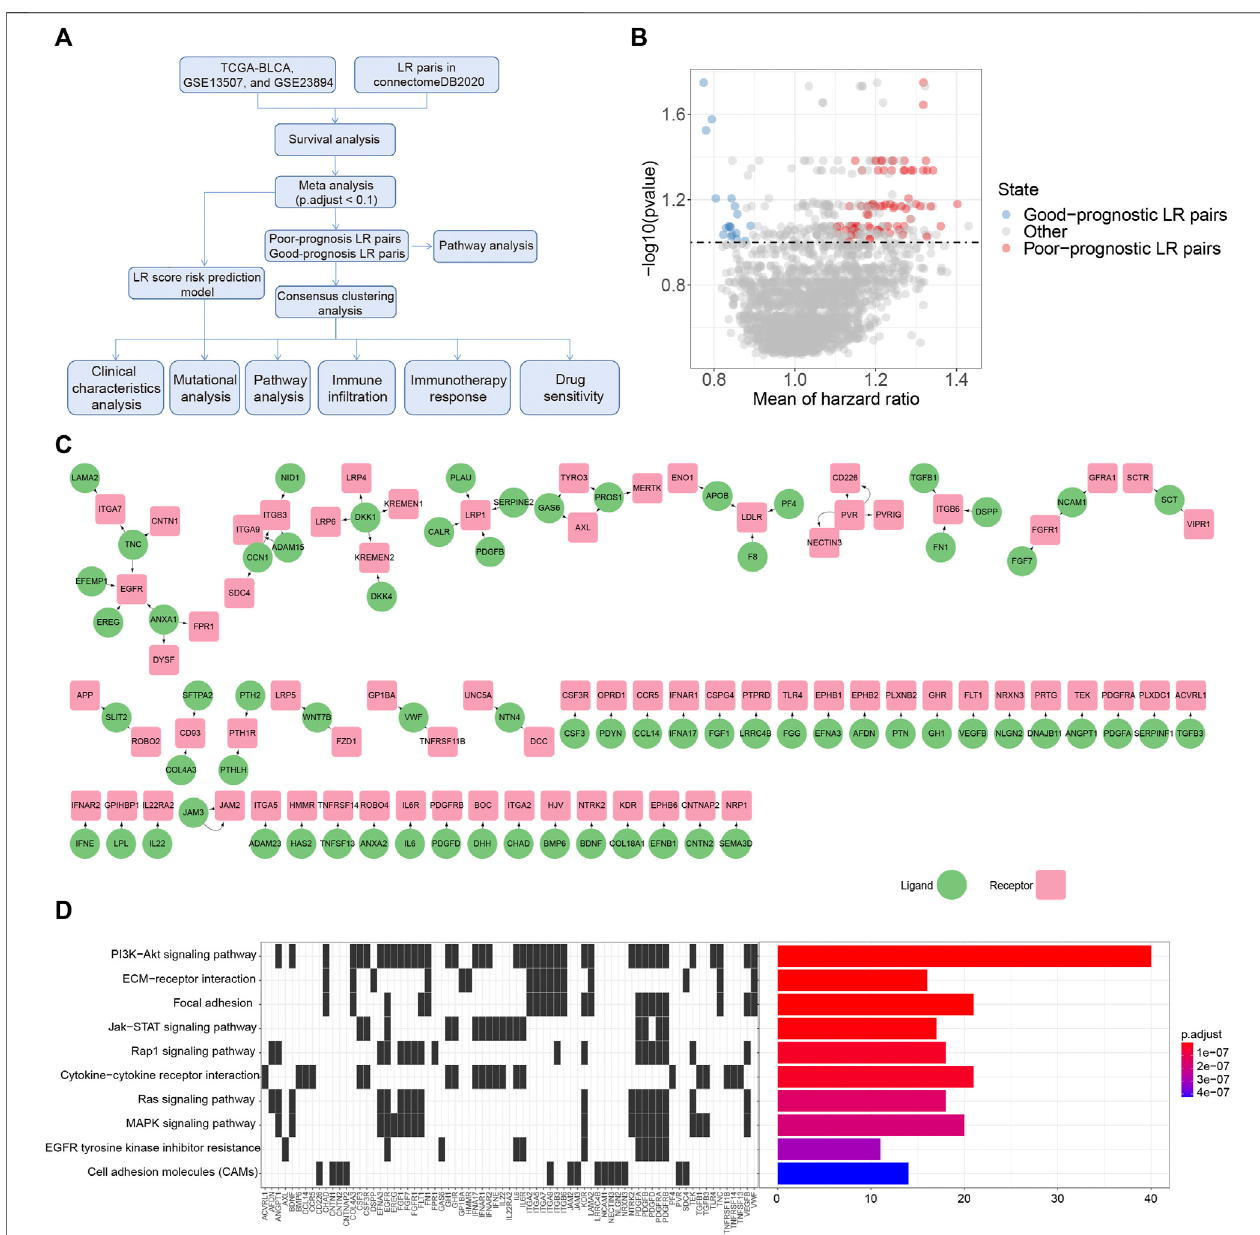
FIGURE1 | Prognostic associated LR pairs selection (A) . The study work fl ow (B) . Volcano plots ofthe distributions of theprognostic signi fi cantLR pairs. Red and blue color represent good- and poor-prognostic LR genes, respectively (C) Interaction network plot of prognostic signi fi cant LR pairs. Red and green color represent receptors and ligands, respectively (D) . Top 10 KEGG pathway enrichment results of prognostic signi fi cant LR pairs.